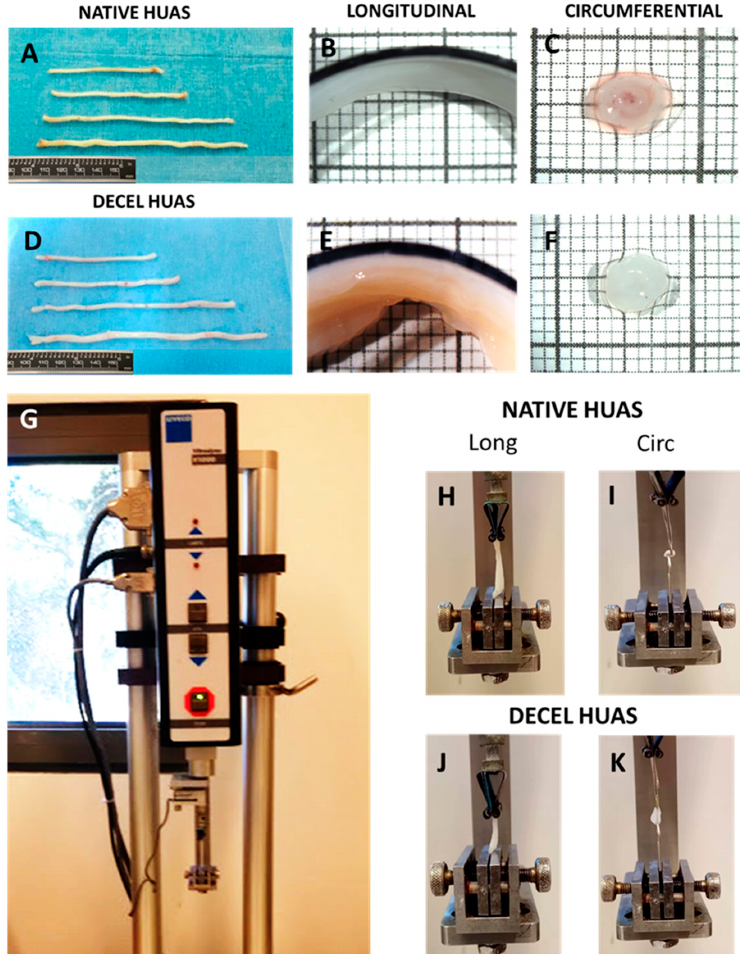
Figure 5. Biomechanical analysis of human umbilical arteries (hUAs). Overview of native and decellularized (decel) hUAs ( A , D ). HUAs segments in longitudinal (log) ( B , E ) and circumferential (circ) direction ( C , F ). Vitrodyne uniaxial testing machine, where the biomechanical analysis of hUAs, was conducted ( G ). Uniaxial testing of native and decellularized hUAs segments in longitudinal ( H , J ) and circumferential ( I,K ) directions.